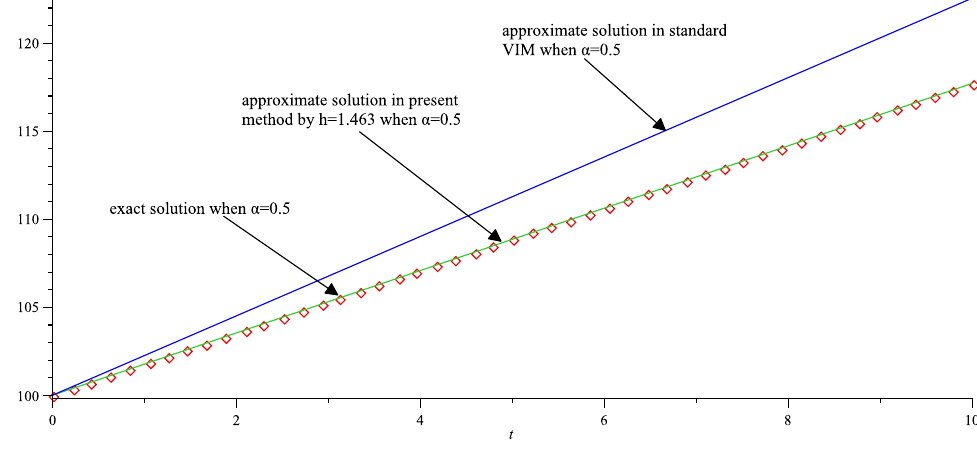
Figure 5. Plots of third-order approximation solutions by present method and standard VIM at x = 10 for α = 0.5 in Example 2.